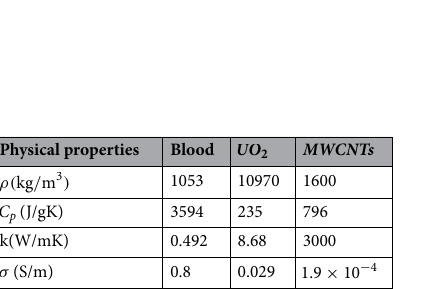
Table 3. Thermophysical properties of blood, UO 2 and MWCNTs 6,54,55 .